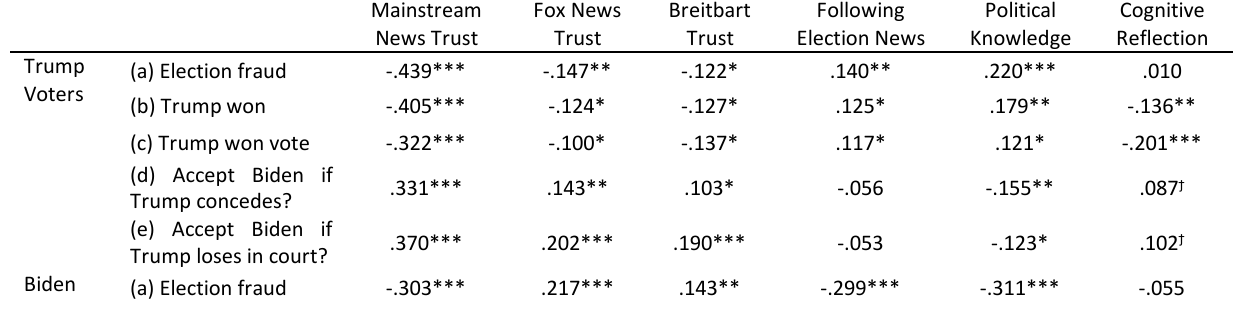
Figure 5. Partisan violence and spite. Percent of Biden (blue) and Trump (red) voters ’ views on select questions relating to partisan spite (top panel) and violence (middle panel). A minority of both Trump and Biden voters wish to break the United States up along party lines (bottom panel). Note that the question wording has been slightly shortened here in some cases. Table 1. Correlations among major